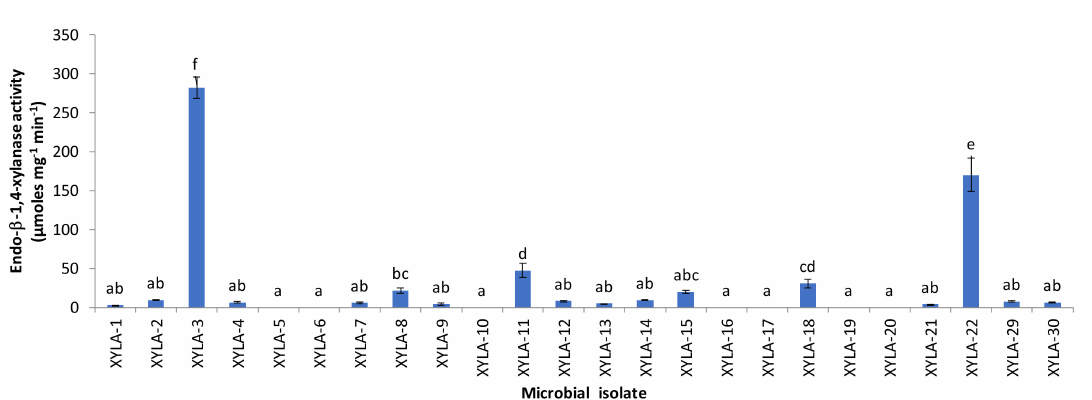
Figure 1. Endo- β -1,4-xylanase activities (surface/intracellular fraction) of the microbial strains isolated from orange juice processing